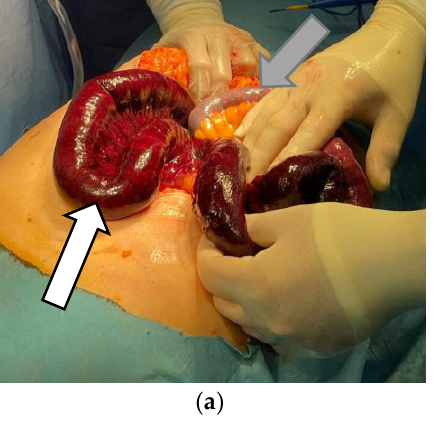
Figure 4. The intraoperative aspect of the bowels. ( a ) the white arrow is pointing toward the ischemic bowel; the grey arrow is pointing towards the normal-looking bowel. ( b ) The white arrow is pointing towards the jejunal stump; the grey arrow is pointing towards the venous thrombus inside the branches of the superior mesenteric vein.